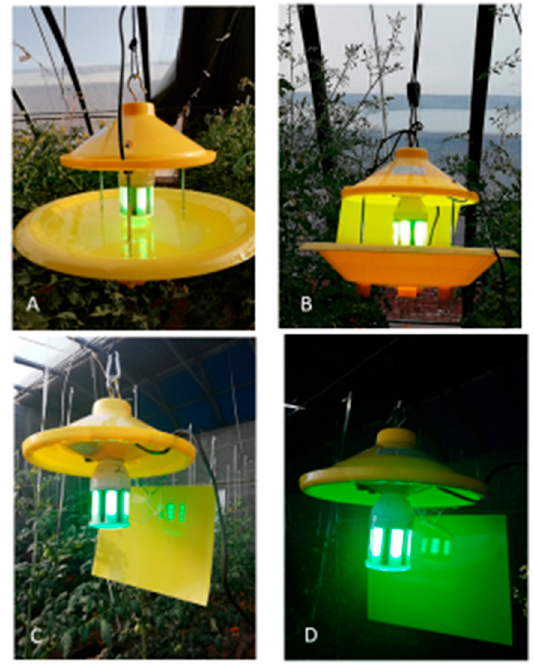
Figure 1. Light emitting diode (LED) traps used in this study. ( A ) LED water pan trap; ( B ) LED water pan trap supplemented with a yellow sticky card; ( C ) LED lit yellow sticky card during the daytime; ( D ) LED lit yellow sticky card during the nighttime.